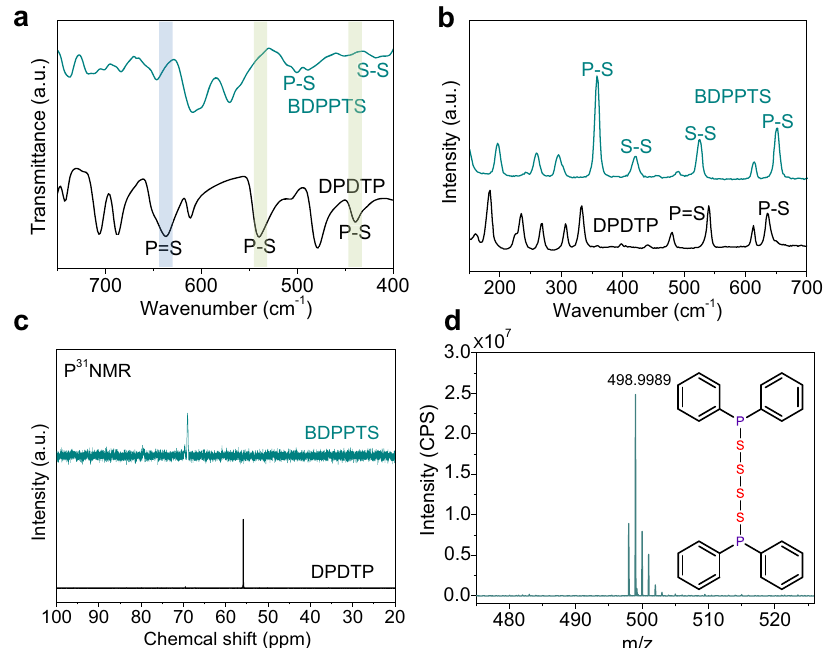
Fig. 2 Chemical characterization of BDPPTS. a FTIR spectra. b Raman spectra. c 31 P NMR spectra of DPDTP and BDPPTS. d Mass spectrometry of